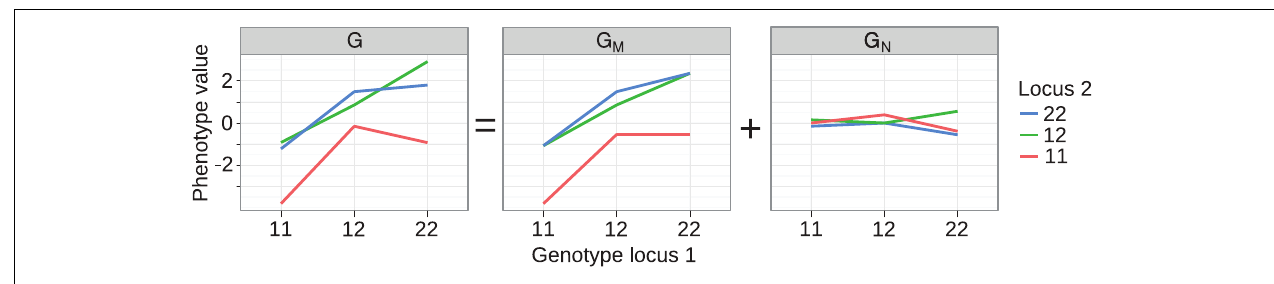
FIGURE 2 | Decomposition of genotype-phenotye map into monotone and non-monotone components. Left panel: Genotype-phenotype map G for two loci underlying 10-week body-weight at 10 weeks in a mouse F 2 cross. The GP map